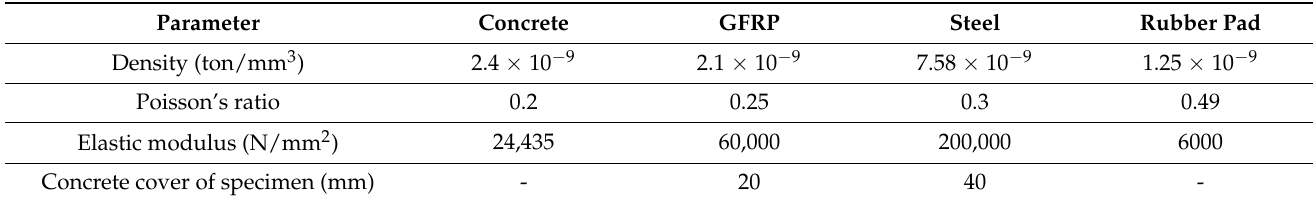
Table 3. Geometric and material properties.